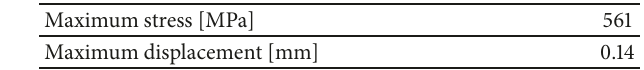
Table 3: Maximum stress in the whole impeller and maximum radial displacement in the interferenceregion between impeller and shaft.